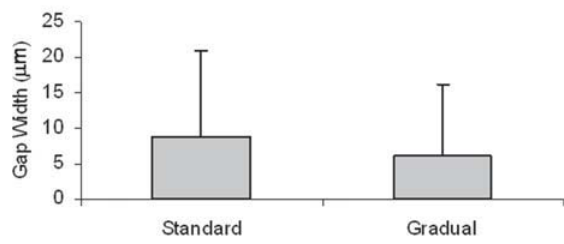
FIGURE 2- Mean gap width (µm) for light-curing protocol as an independent factor (vertical bar represents the standard deviation)